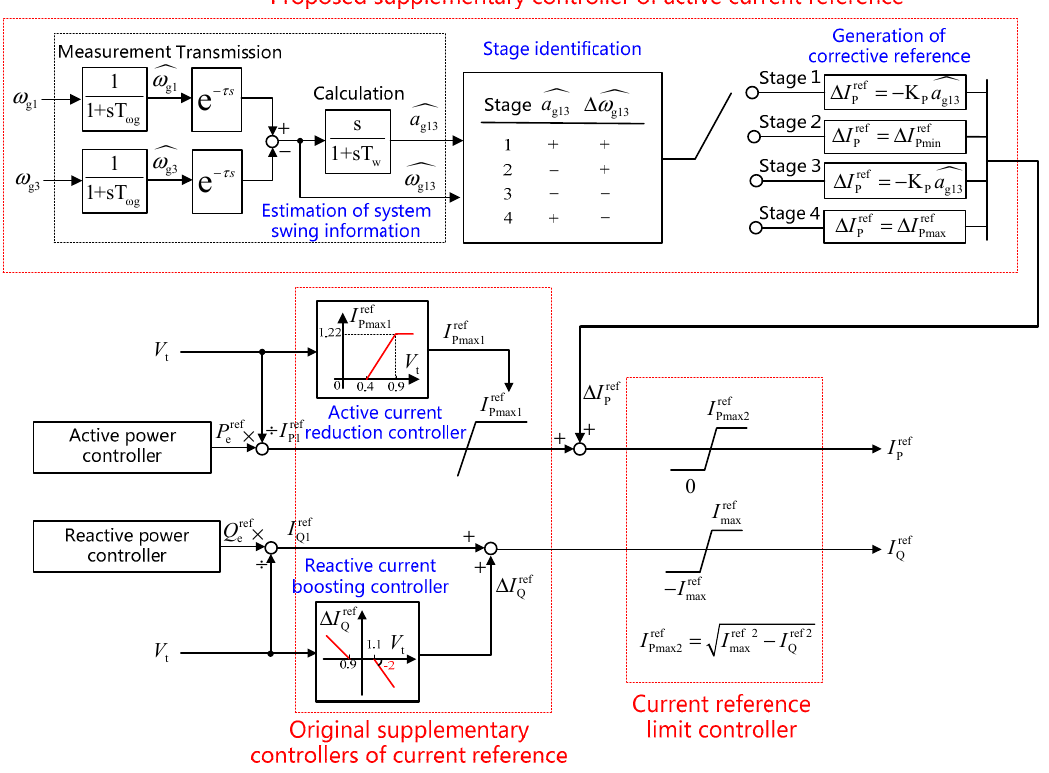
Figure 8. Schematic diagram of parts of the aggregated wind turbine model with the proposed controller.